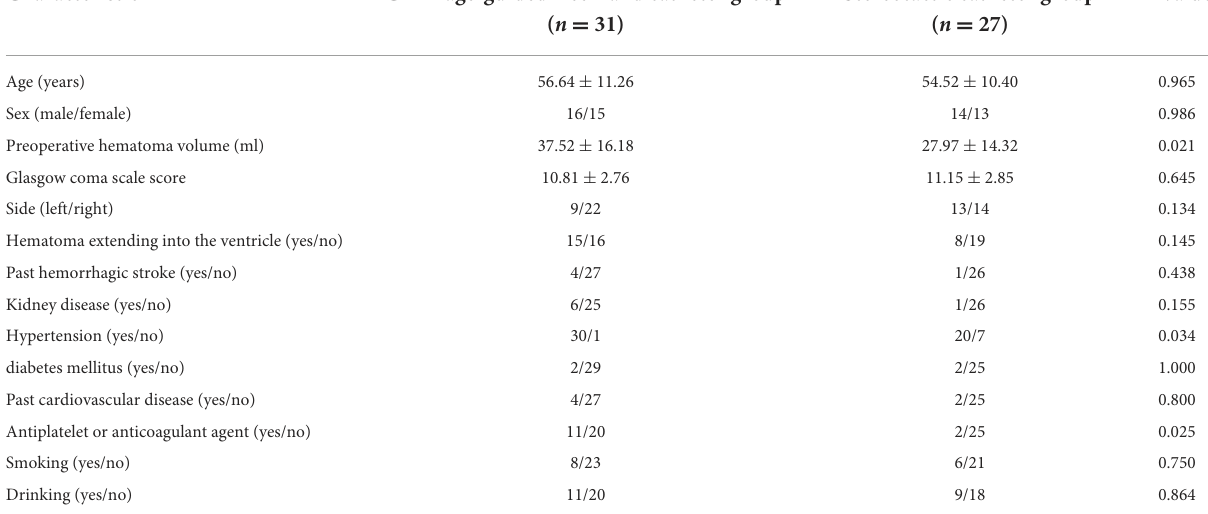
TABLE 1 Characteristics of the patients at